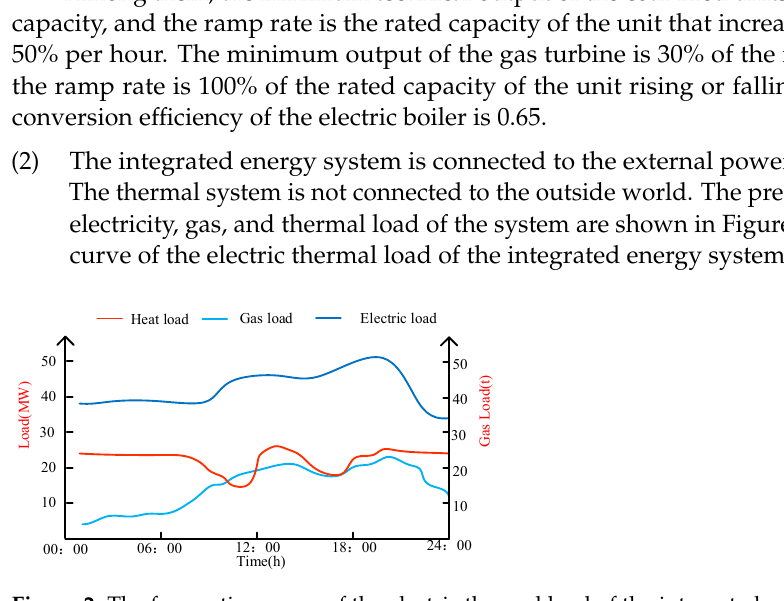
Figure 2. The forecasting curve of the electric thermal load of the integrated energy system. The predicted output data of wind turbines and photovoltaic units is shown in Figure